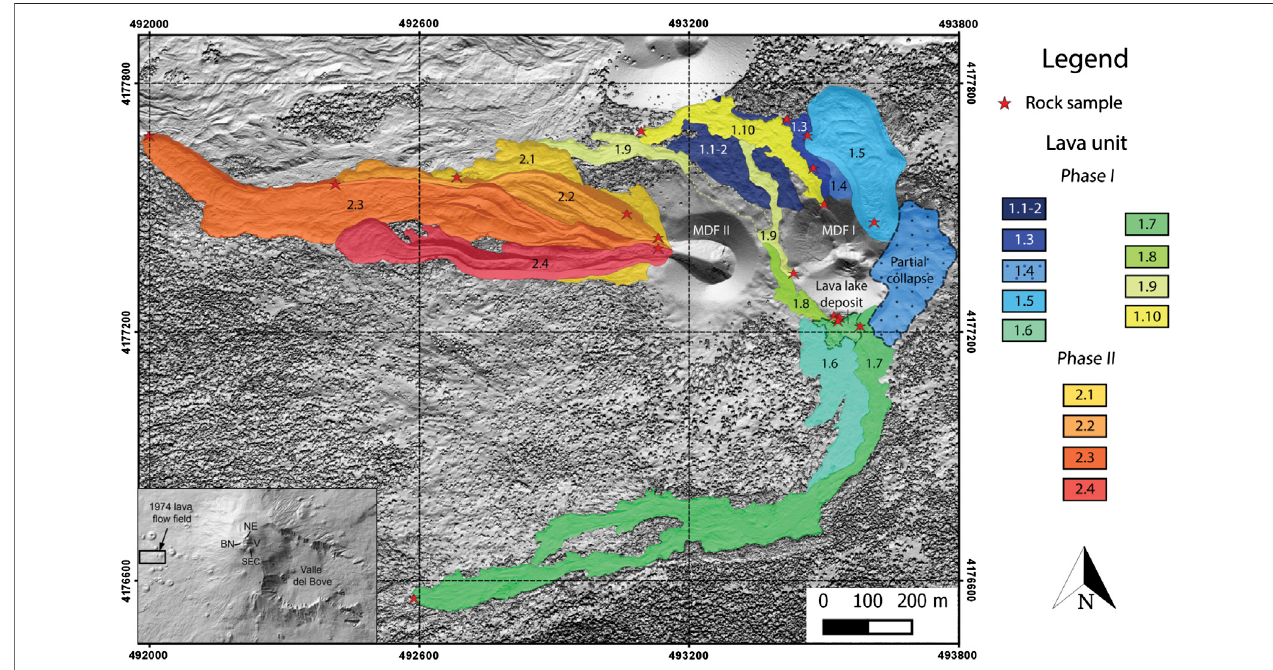
FIGURE 2 | Geological map of the January – March 1974 west fl ank eruption of Mount Etna overlain on the DEM (as shaded relief) of Favalli et al. (2018), with locations (red stars) of the 19 samples that were used for further analysis. Lava fl ow units are numbered in chronological order (see Table 2 for dates of emplacementof each unit). Inset locates the area of the magni fi cation on the Etna DEM (as shaded relief) of Favalli et al. (2009b). On the inset the four summit craters are marked: NE Crater (NE), Bocca Nuova (BN), La Voragine (V) and South East Crater (SEC).